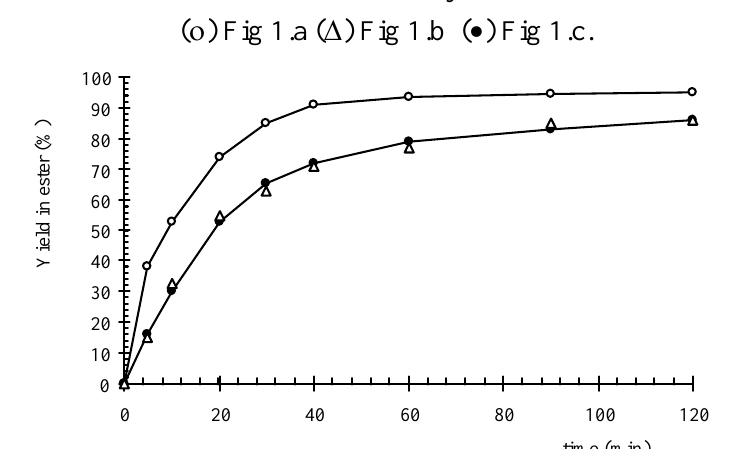
Figure 2. Influence of the location of the catalyst in continuous microwave